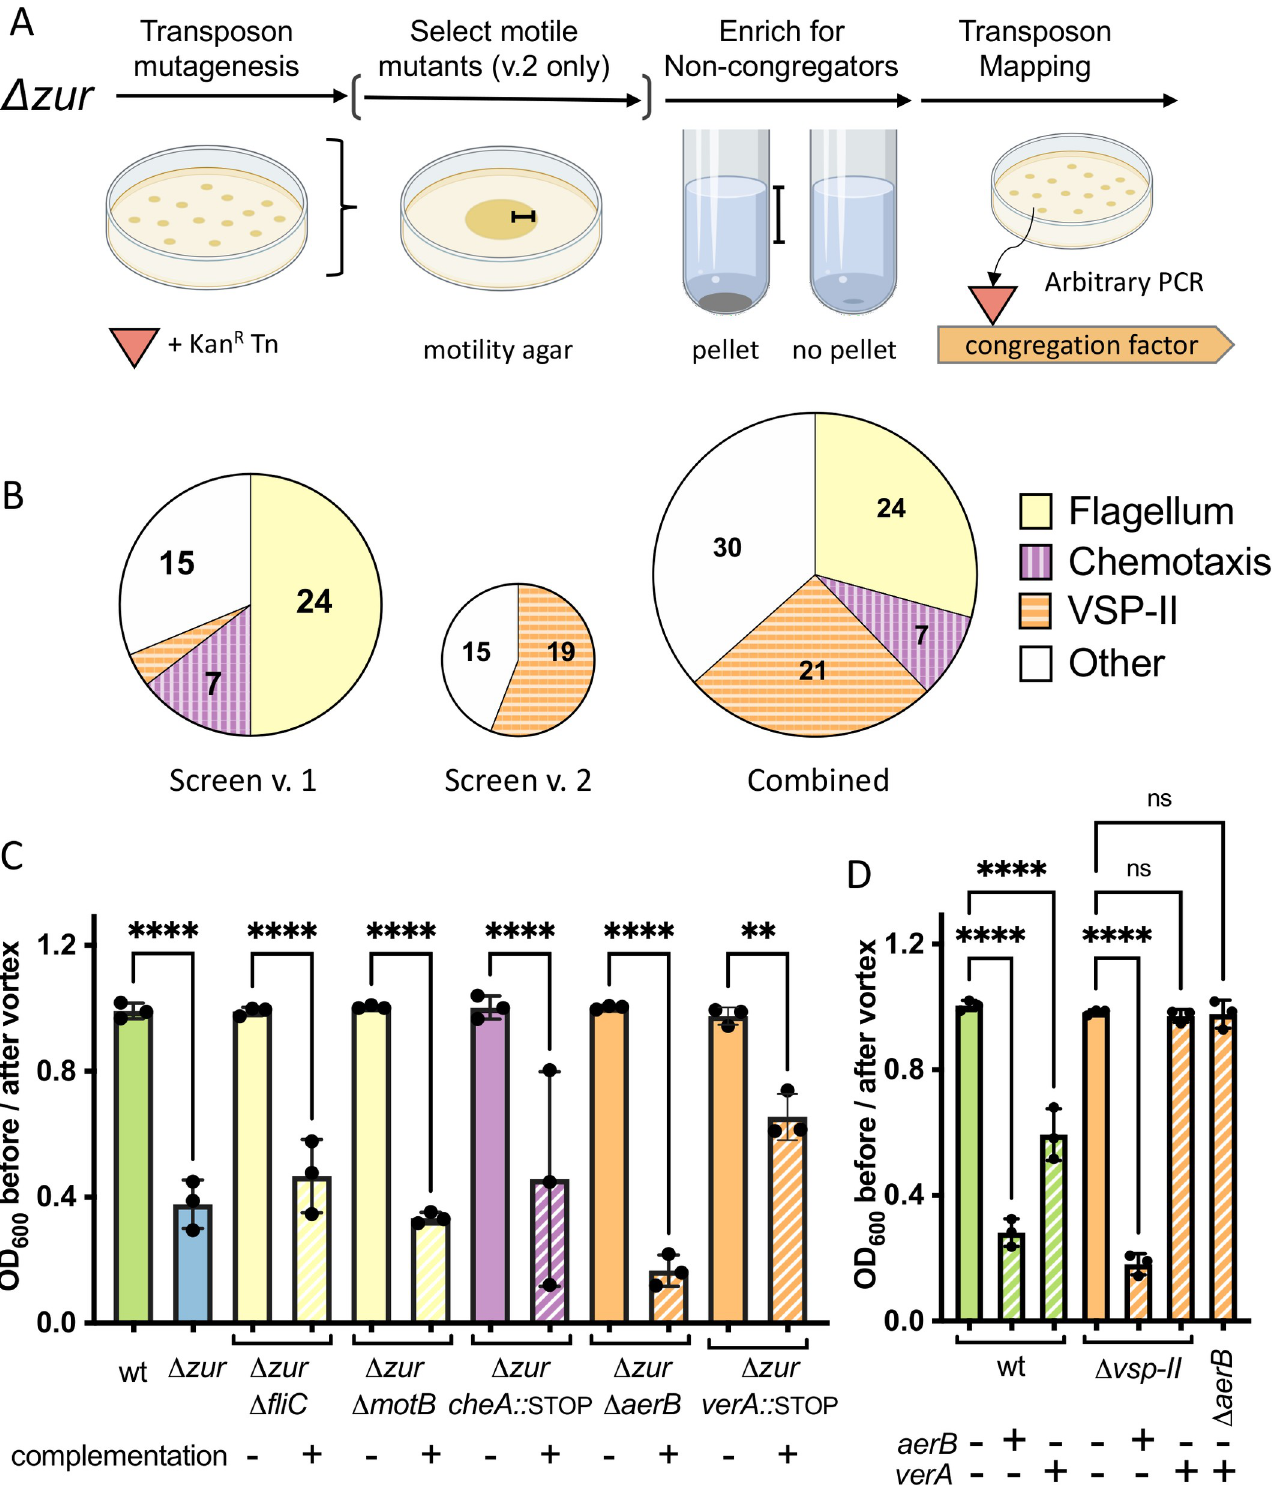
Fig 2. Δ zur congregation requires motility and components of VSP-II. ( A ) Δ zur was mutagenized with mariner transposons to generate a library of insertion mutants (see Methods for details). Non-congregating mutants within the library were enriched via repeated subculturing of the supernatant until no pellet formed. Brackets indicate harvested zones. Transposon insertions were mapped using arbitrary PCR. In a modified version of this screen (v.2), the transposon